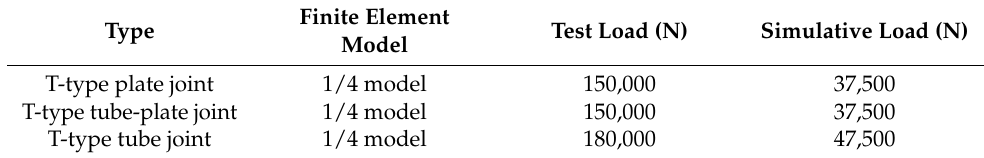
Table 9. Loads for each joint type.